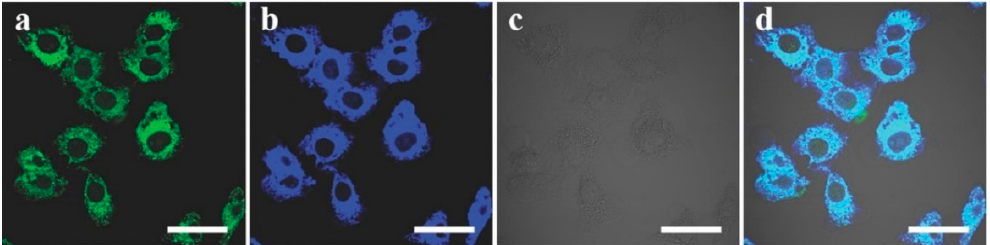
Figure 28. ( a ) CLSM image of HeLa live cells stained in LysoTracker, ( b ) CLSM image of HeLa live cells incubated in DMEM culture medium containing MoS 2 QDs, ( c ) corresponding bright-field image, ( d ) overlapped image of the living cells. Reproduced with permission from [43]. Copyright 2015 WILEY-VCH Verlag GmbH & Co. KGaA (Weinheim, Germany).